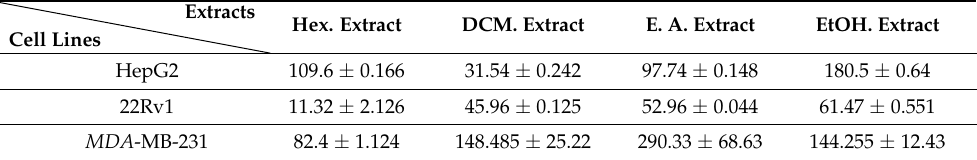
Figure 5. Cytopathic effects in MDA-MB-231 cancer cells after 72 h post-treatment with increasing concentration of Cistus ladanifer hexanic extract. Table 3. IC 50 values of C. ladanifer extracts in cancer cells after being treated for 72 h. Values are expressed in µg of dry extract per mL.